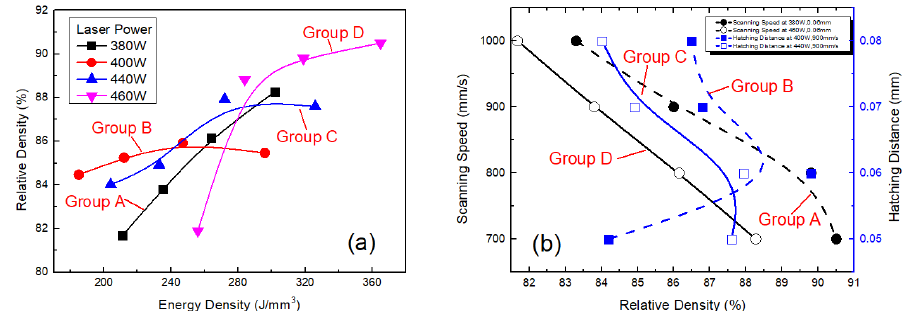
Figure 6. Relative density of the alloy formed by SLM under different process parameters: ( a ) relative density of the alloy versus energy density (laser power is labeled according to different groups via different symbols and legends) and ( b ) scanning speed and hatching distance versus the relative density of the alloy.